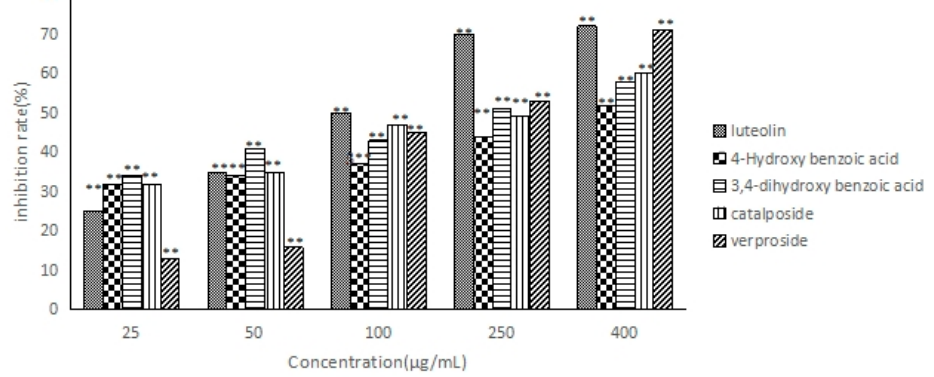
Figure 5. Cell proliferation inhibition rate of five compounds. ** p < 0.01, statistically significant in comparison with the control.